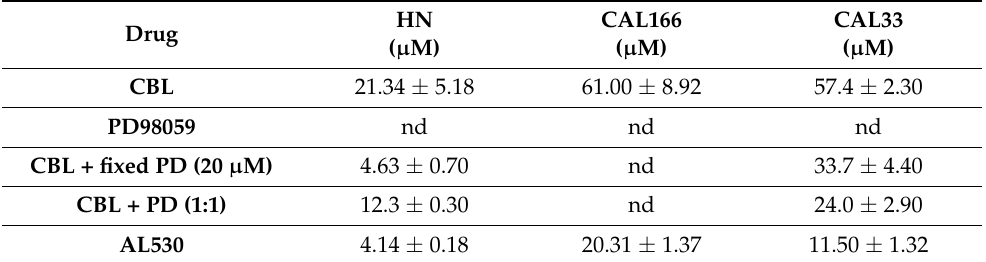
Table 2. Growth inhibition in HN, CAL166 and CAL33 cell lines treated with different doses of AL530, CBL, PD98059 and combinations of CBL plus